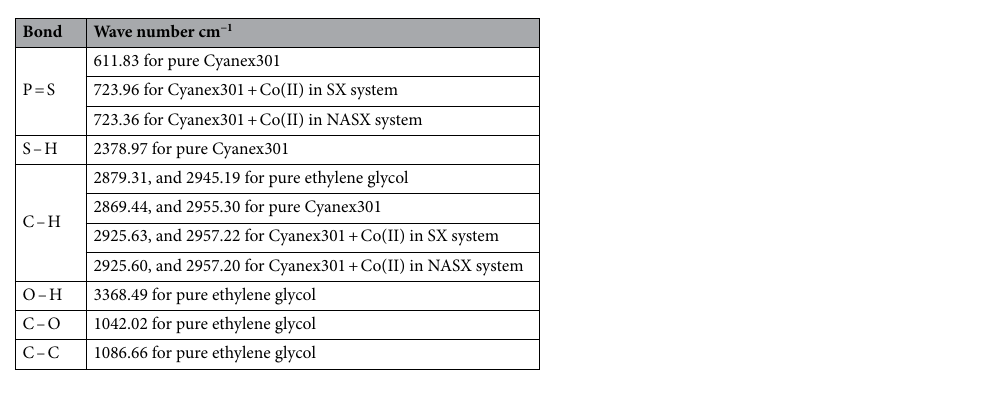
Table 5. Characteristic vibrational bands from FTIR